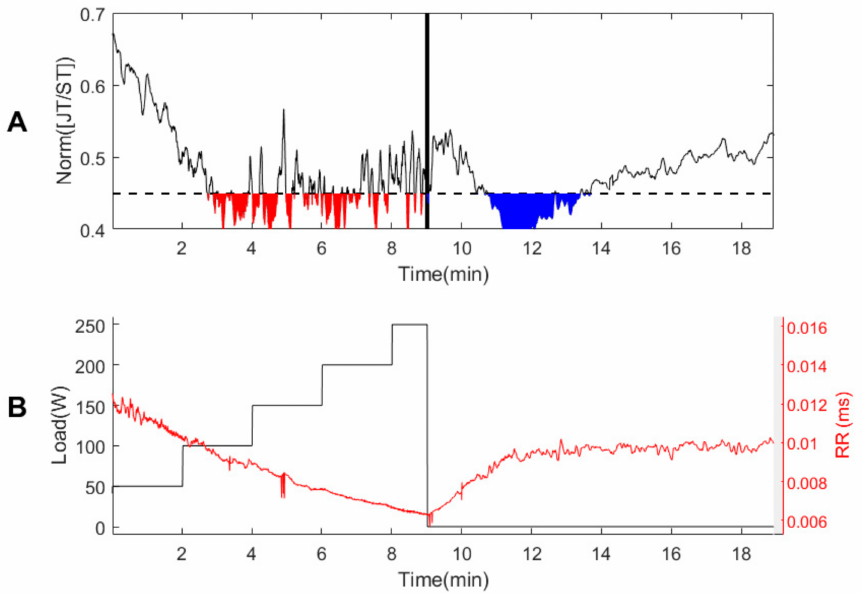
Figure 5. The dynamics of the JT/ST relationship during the load and recovery processes for person #4. The x -axis in parts ( A , B ) represents the time (measured in minutes) from the beginning of the cycle ergometry exercise. The left y-axis in part ( B ) represents the power of the load in Watts. The right y-axis in part ( B ) represents the variation of the RR interval in ms. The algebraic JT/ST relationship is represented by the thin dashed black line in part A. The thick black solid vertical line in part A marks the end of the load.